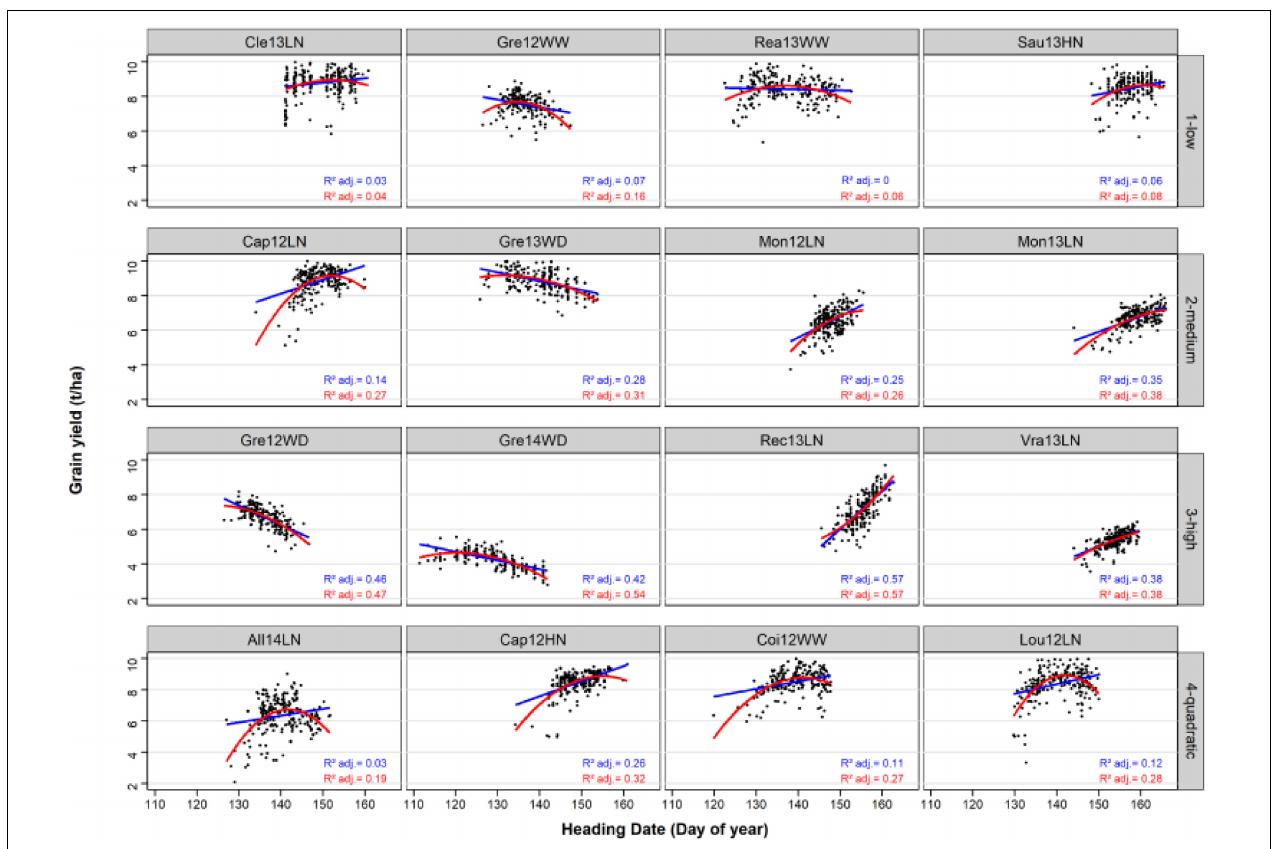
FIGURE 2 | Linear and quadratic regressions of GY on HD in the 16 environments and the 220 bread wheat varieties. The linear and the quadratic adjustments are represented by a blue line and a red curve, respectively. Adjusted R 2 are indicated for the linear (in blue) and for the quadratic (in red)